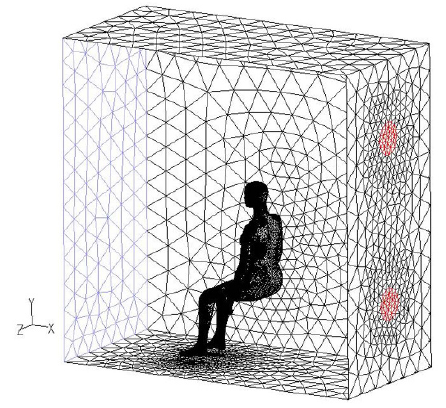
Figure 5. Velocity vectors in a midplane, coloured by magnitude [m/s].